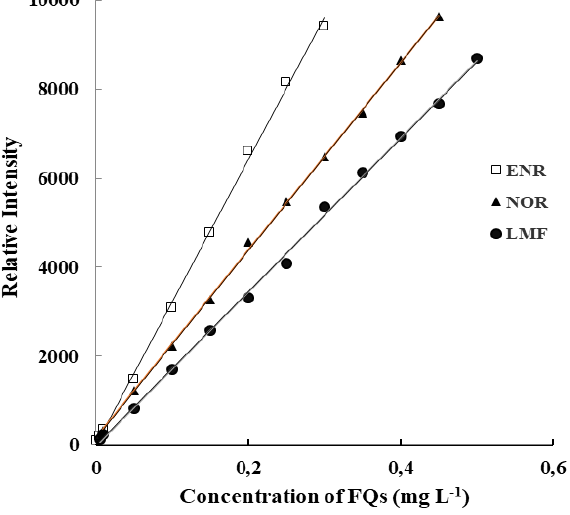
Figure 3: the alongside with the approximation line for each of the FQ.